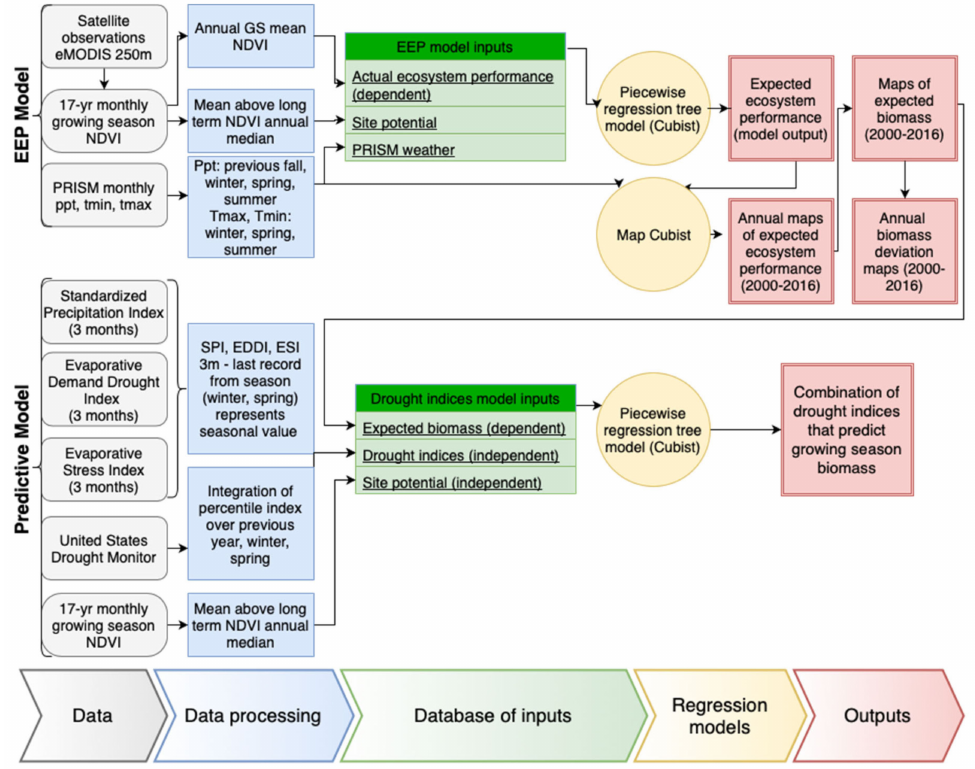
Figure 1. Flowchart of the modeling process and data used to generate the Expected Ecosystem Performance (EEP), interannual biomass deviation (EEP model), and predictions of expected biomass at di ff erent time steps (predictive